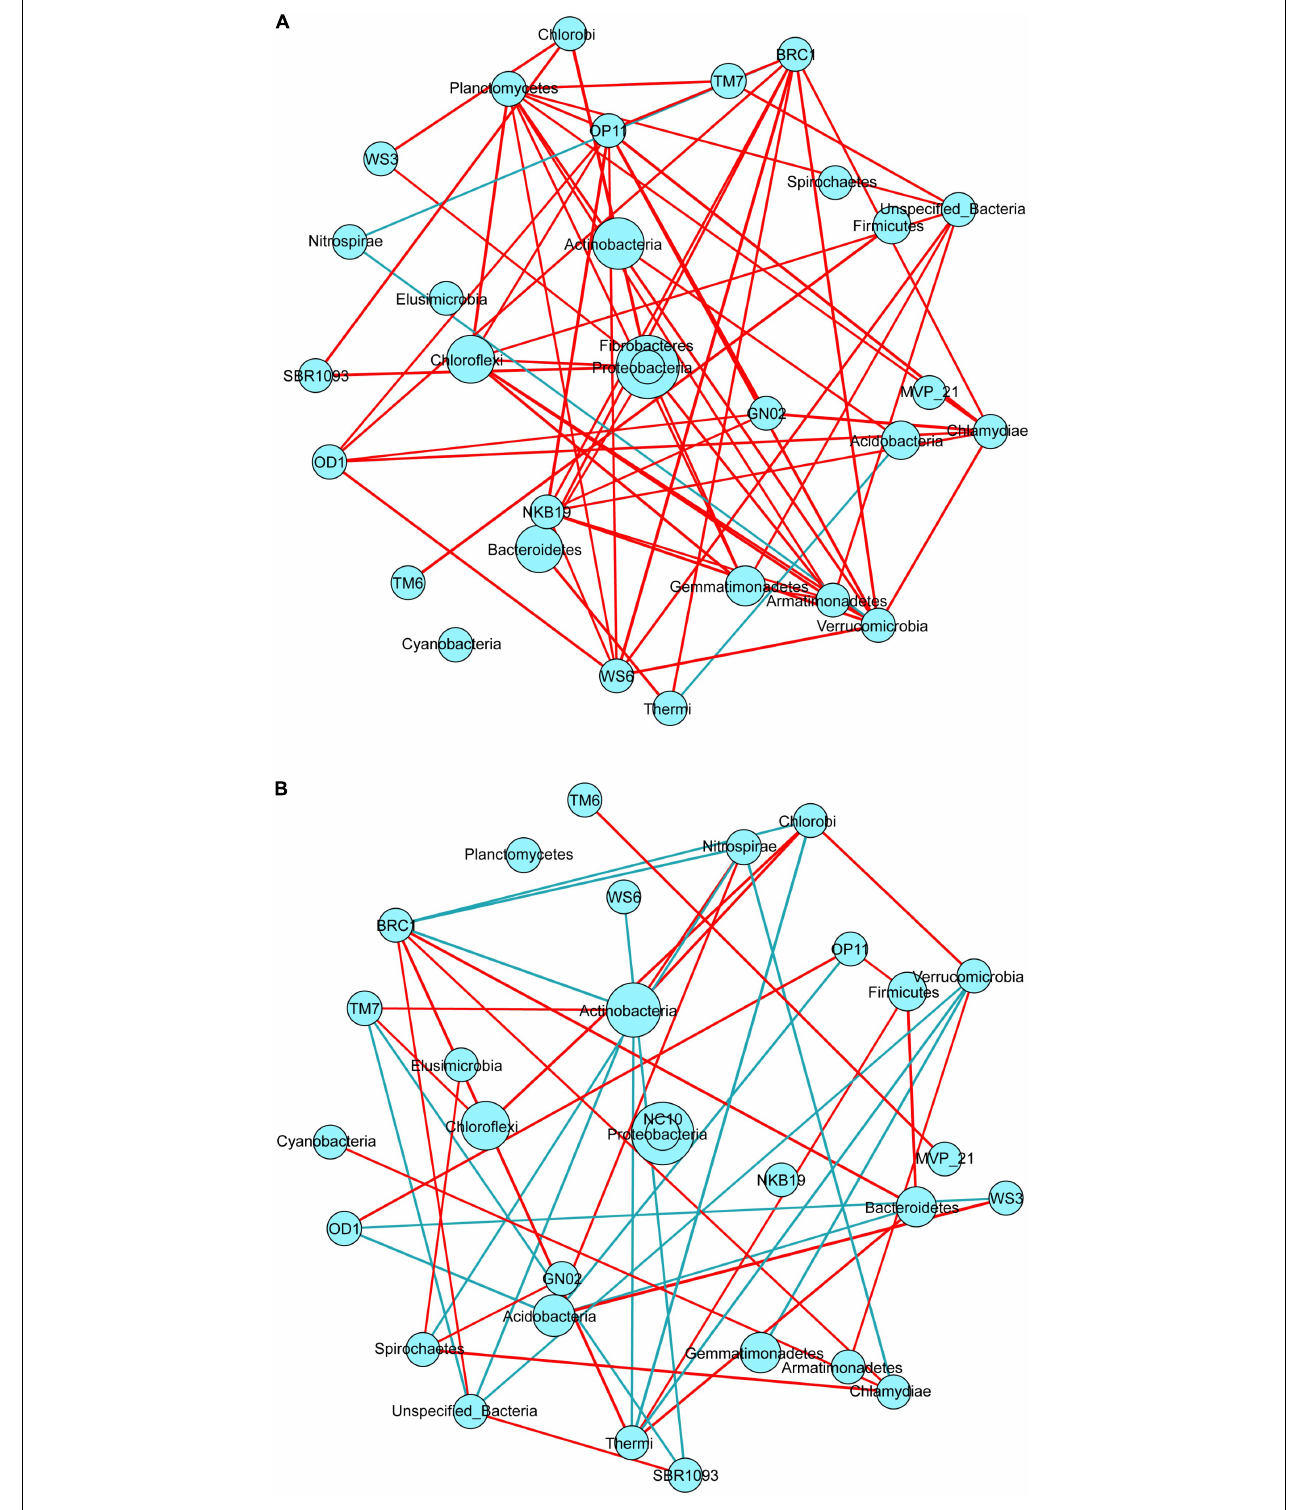
FIGURE 6 | Symbiotic network analysis of soil bacterial communities in the rhizosphere (A) and bulk (B) of three halophytes (correlation threshold > 0.5). Nodes in the network diagram represent bacterial gates, and the size of each node is in direct proportion to the relative abundance. The red connection line represents a positive correlation between bacteria, whereas the blue connection line represents a negative correlation between bacteria.